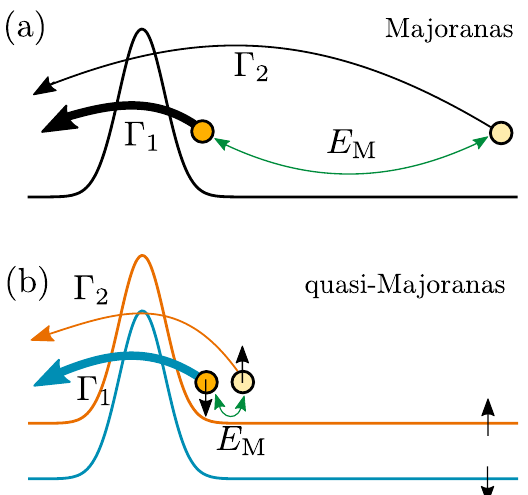
Figure 1: Schematic drawing of couplings of (quasi-)Majorana states. (a): Couplings in the topological regime with spinless Majorana states. The spatially separated Majorana states have a coupling energy E (green arrow), and couple with coupling M (cid:29) Γ strengths Γ , Γ across the tunnel barrier. The arrow thickness indicates that Γ . 1 2 1 2 (b): Couplings in the quasi-Majorana regime with two quasi-Majoranas, located at the tunnel barrier slope and with a suppressed coupling E , experience a different M effective barrier due to their opposite spin and the finite magnetic field. The spin- down quasi-Majorana state (dark yellow) couples strongly with coupling strength Γ 1 (thick blue arrow, blue effective barrier), the quasi-Majorana state with spin-up (faint yellow) couples weakly with coupling strength Γ (thin orange arrow, orange effective 2